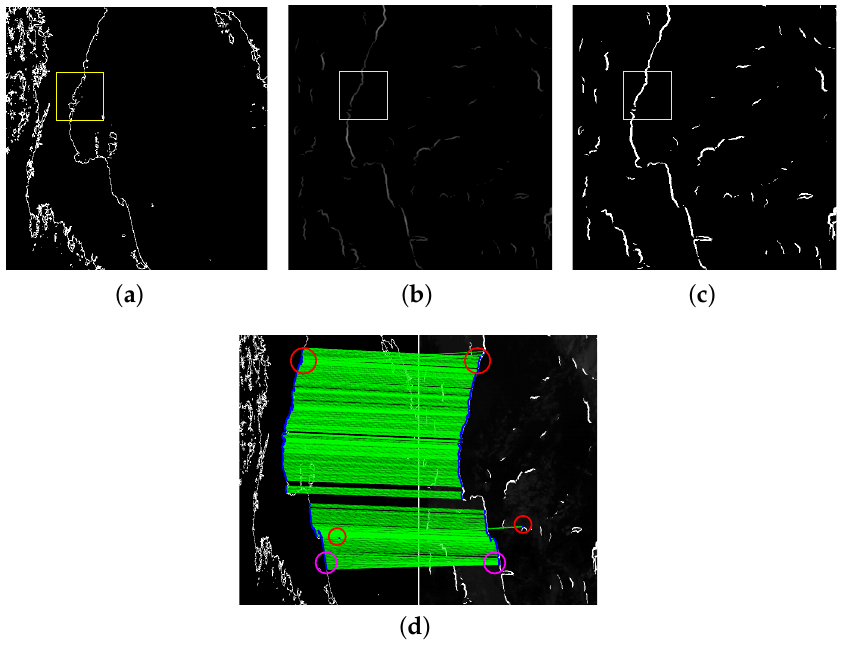
Figure 1. The landmarks and GSMS images in the southern coastal area of Thailand and their initial matching results. These points in circles are outliers. ( a ) landmarks; ( b ) edge probability image; ( c ) edge binary image; ( d ) initial